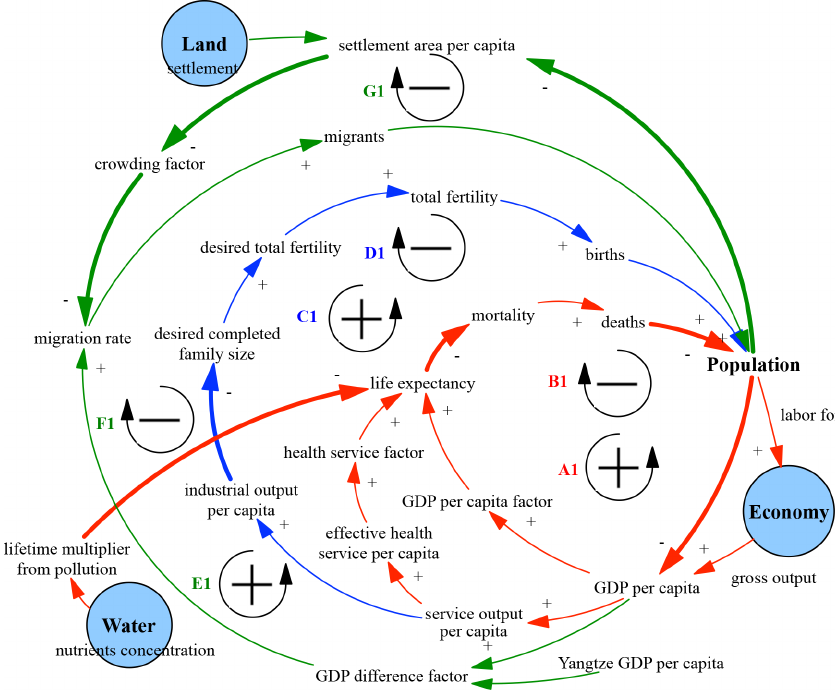
Figure 3. CLD in the population sector.